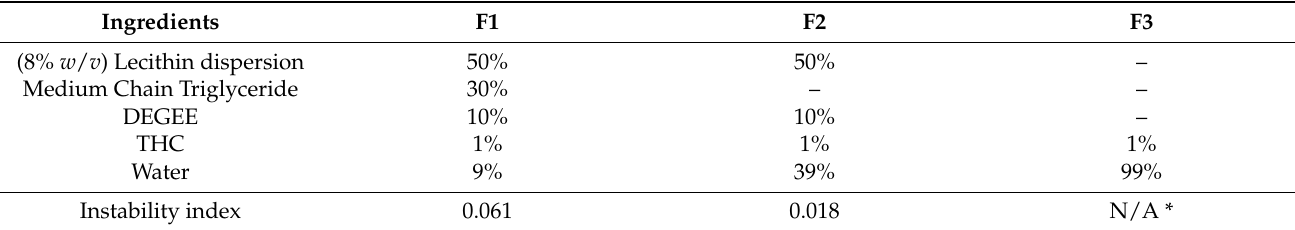
Table 4. Compositions of the formulations F1, F2, and